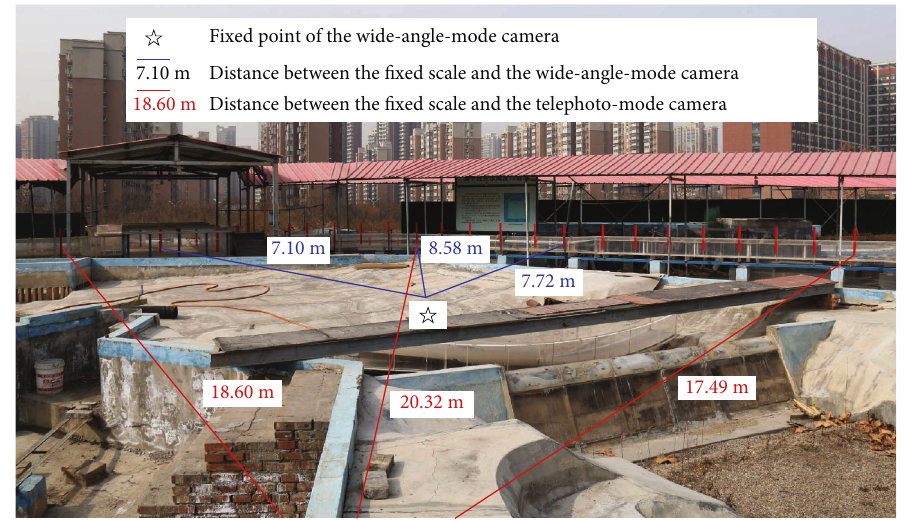
Figure 2: The position relationship between the single-camera position and the fi xed scale (two options).